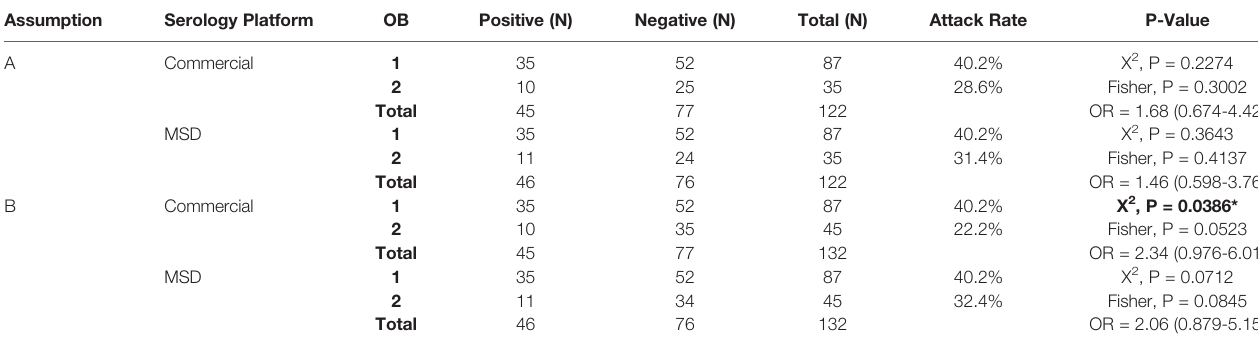
TABLE 1 | Summary of sero-survey